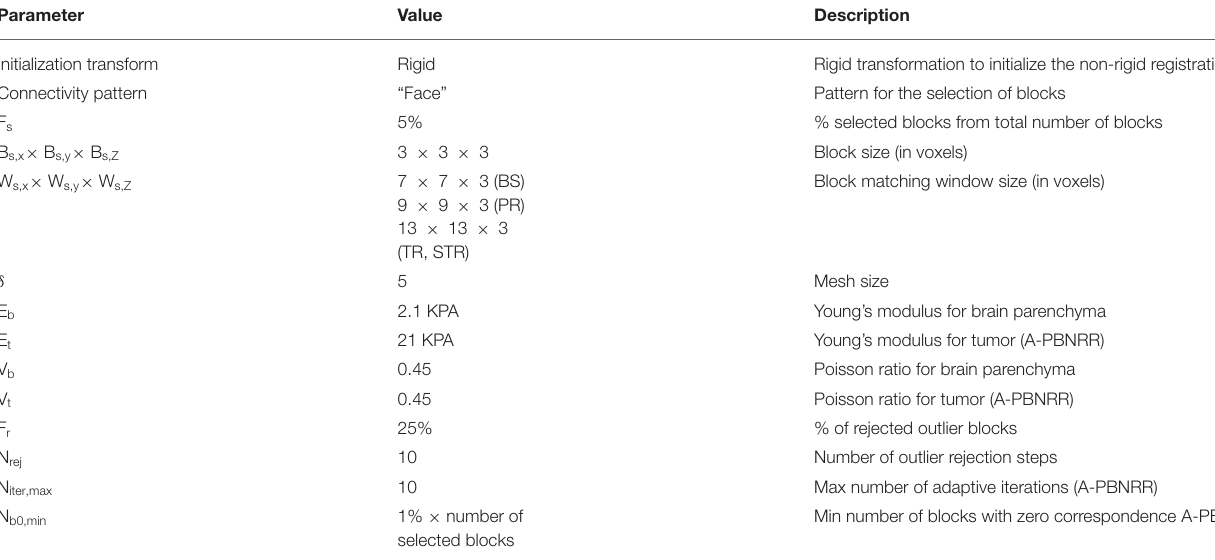
TABLE 3 | Parameters used for PBNRR and A-PBNRR. Parameter Value Description Initialization